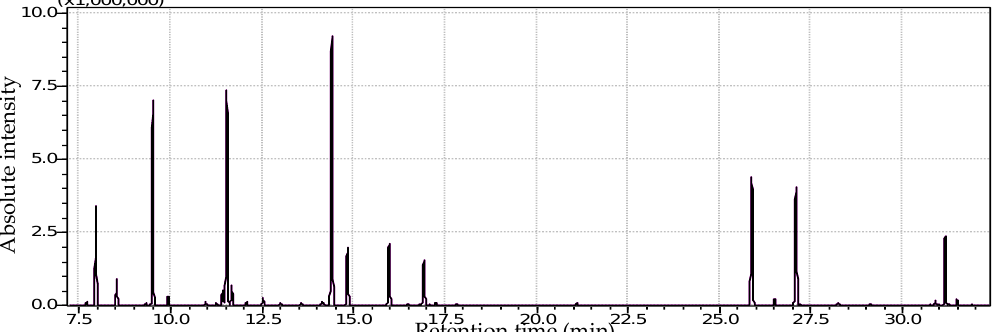
Figure 4. GC-MS chromatogram of the essential oil obtained from Salviae folium, by classical extraction with Neo-Cleavenger.